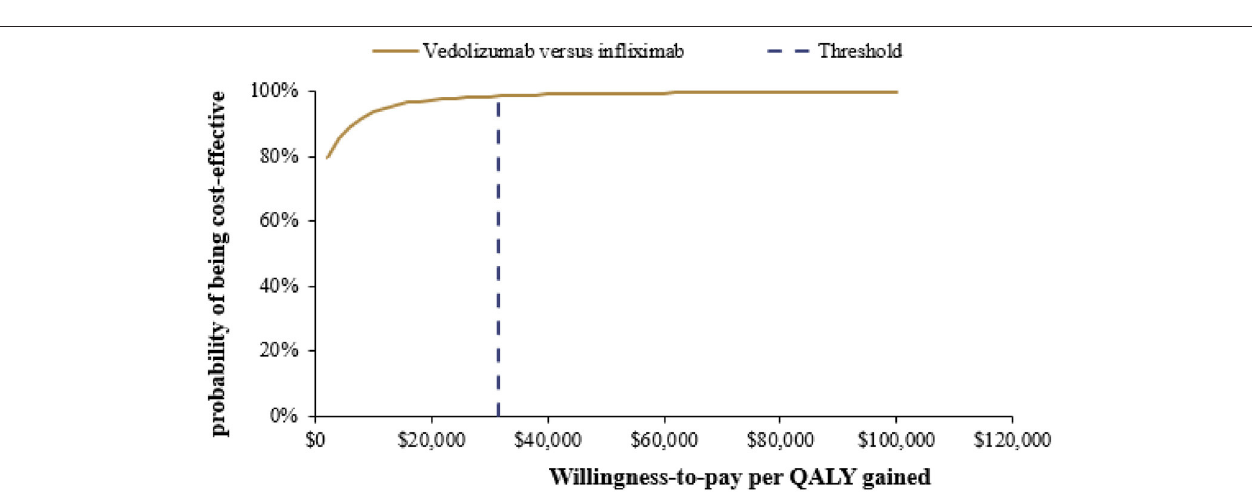
FIGURE 2 | One-way sensitivity analysis results. CT, conventional therapy, IFX, infliximab, VDZ, vedolizumab; CI, confidence interval.